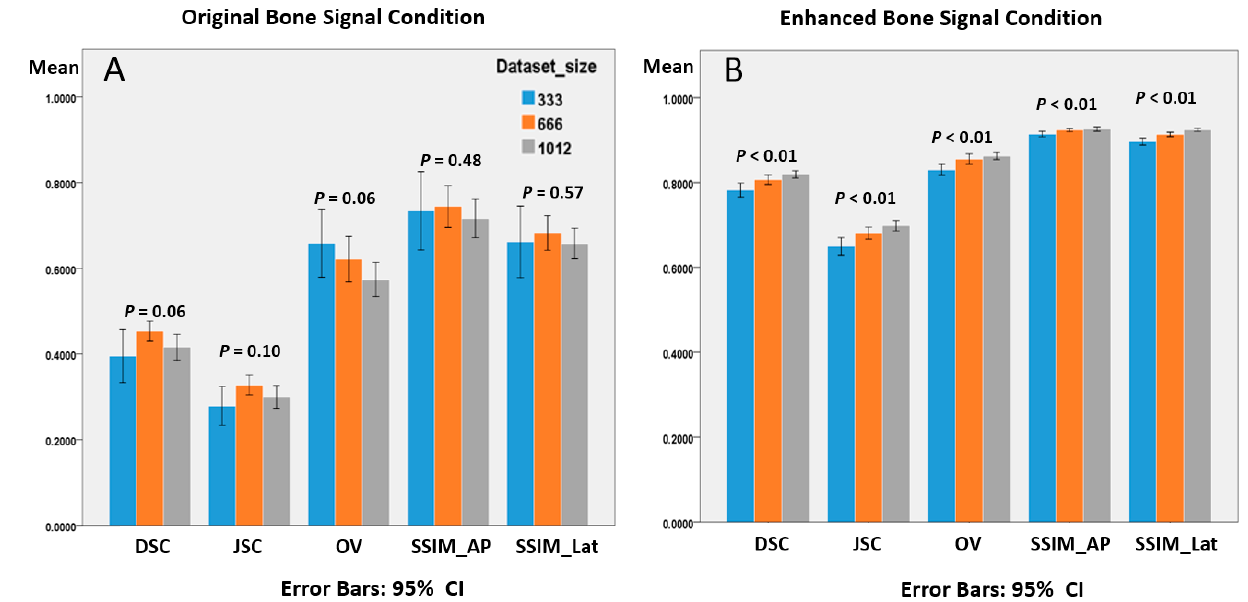
Figure 8. ( A , B ) Training performance between different training dataset sizes in original and en- hanced bone signal conditions . CI: confidence interval.